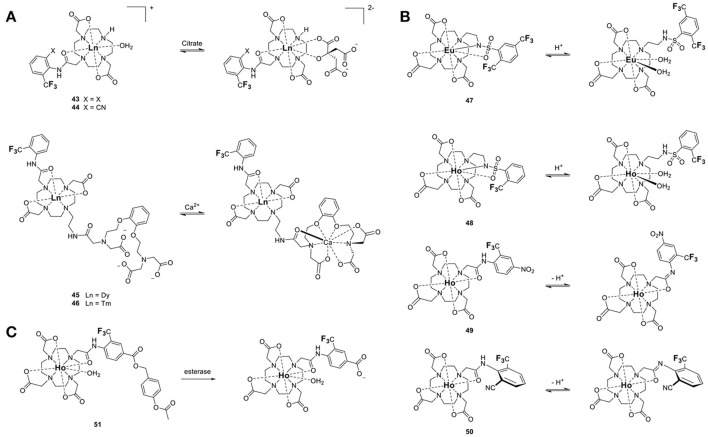
Responsive 19F-Ln probes that induce a chemical shift (19FΔδ) by (A) modulating the coordination environment of the LnIII and hence its second order crystal field coefficient, B20, (43–44, Harvey et al., 2012a; 45–46, Harvey et al., 2012a), (B) altering B20 and the angle θ between the LnIII-19F vector and the principle magnetic dipolar axis of the lanthanide upon changes in protonation (47, Senanayake et al., 2007; 48–49, Kenwright et al., 2008; 50, Chalmers et al., 2010), or (C) following a chemical reaction (51, Harvey et al., 2012a).